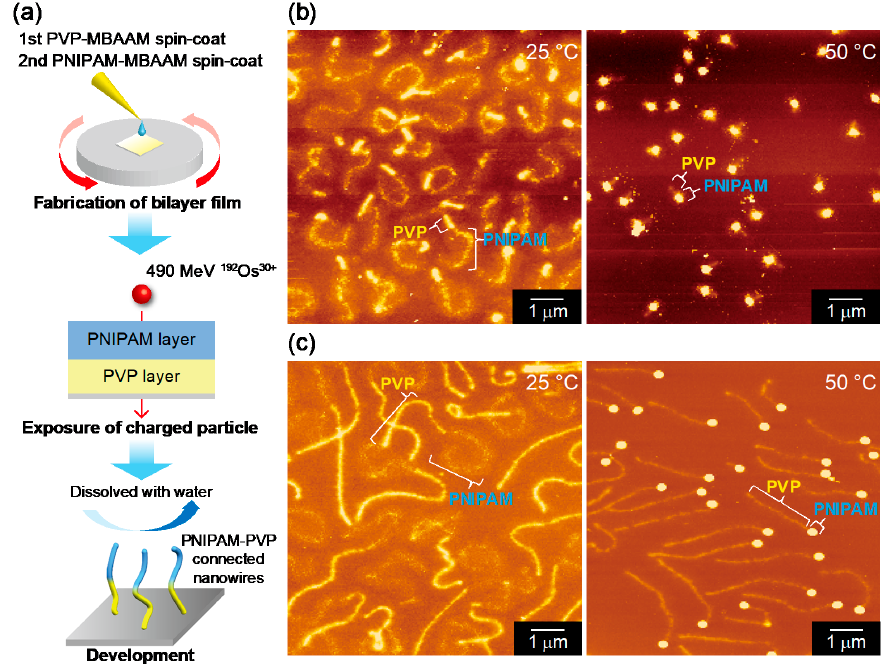
Figure 4. ( a ) Schematic representation of the formation of PNIPAM − PVP connected nanowires by SPNT from a PNIPAM layer (PNIPAM/MBAAM = 100/20) (upper) and a PVP layer (PNIPAM/MBAAM = 100/20) (lower) bilayer. ( b , c ) AFM topological image of PNIPAM − PVP connected nanowires with 0.1 and 0.5 μ m thicknesses of PVP layer treated in water at 25 °C (left) and then 50 °C (right). PNIPAM − PVP connected nanowires were formed by irradiation of the bilayer films (b: PNIPAM layer/PVP layer = 0.5 μ m/0.1 μ m, c: PNIPAM layer/PVP layer = 0.5 μ m/0.5 μ m) with